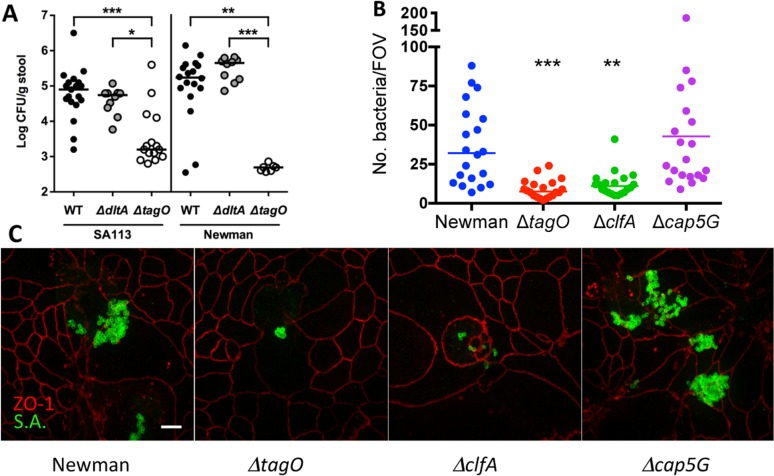
Effects of WTA on S. aureus GI colonization and the influence of surface antigens on in vitro adherence of S. aureus to T84 cells.
A) Fecal cultures were performed 7 d after bacterial inoculation with 109 CFU S. aureus. Each dot indicates the CFU S. aureus/g stool for a single mouse, and the median of each group of animals is indicated by a horizontal line. The lower limit of detection by culture was ~2.5 log CFU/g stool. P-values were determined by Kruskal-Wallis test with Dunn’s multiple comparison test. B) At an MOI of 100, Newman ΔtagO and ΔclfA were less adherent in vitro to T84 intestinal epithelial cells than WT strain Newman, as measured by the number of adherent S. aureus per field of view (FOV). * P < 0.05; ** P < 0.01; *** P < 0.001. C) The relative adherence of strain Newman and its isogenic mutants lacking WTA (ΔtagO), ClfA, or capsular polysaccharide (Δcap5G) to T84 cells in vitro was viewed by confocal microscopy. Immunostaining was performed with mouse anti-ZO-1 (red) to visualize the T-84 apical tight junctions and S. aureus rabbit antiserum to identify the bacteria (green). Scale bar, 10 microns.